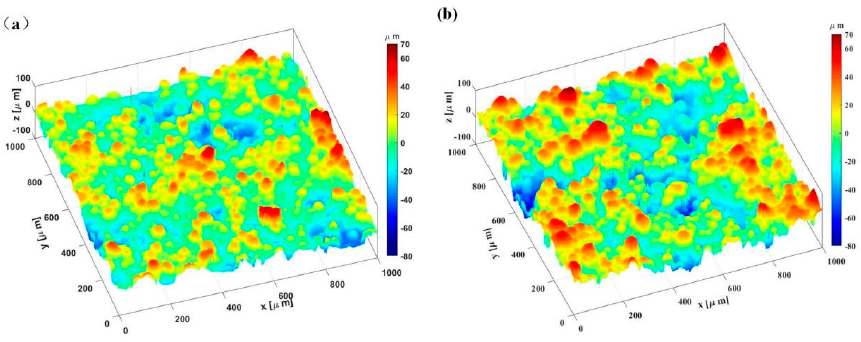
Figure 1. Three − dimensional morphologies of specimen surfaces ( a ) pure PA12 ( b ) SiC/PA12 com- posites.